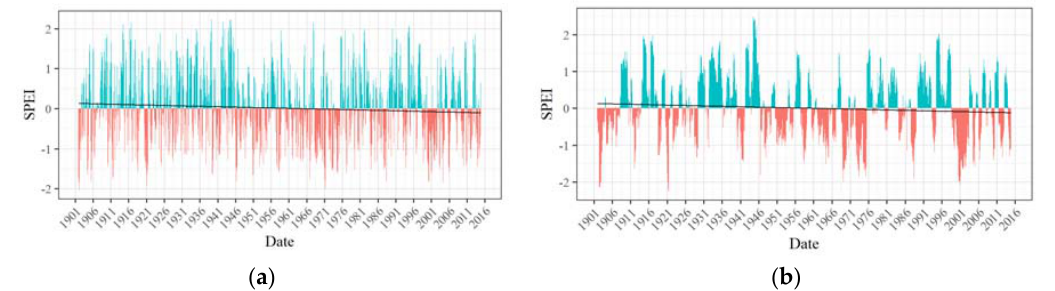
Figure 9. ( a ) 3 ‐ month and ( b ) 12 ‐ month time series of Zone 5.